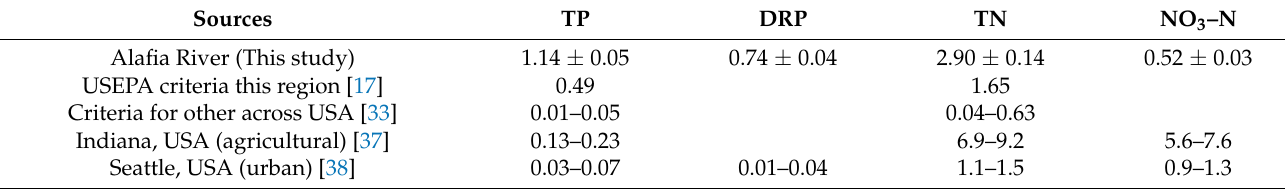
Table 4. Comparison of concentrations (mg L − 1 ) of total phosphorus (TP), dissolved reactive phosphorus (DRP), total nitrogen (TN), and nitrate-nitrogen (NO 3 –N) between this study and previous studies for the United States. Sources TP DRP TN NO 3 –N Alafia River (This